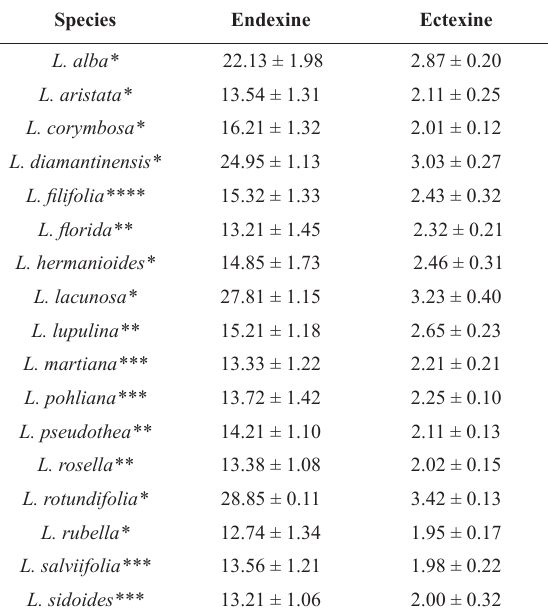
Pollen morphological data (mean values and standard deviations of colpi in μm) of Lippia species. Clg = colpus length, Clt = colpus width.